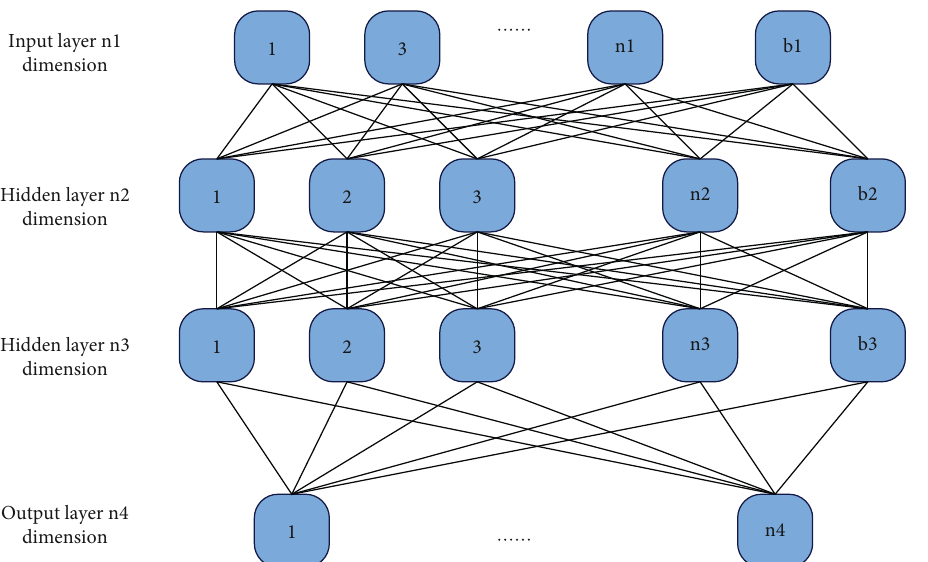
Figure 6: Schematic diagram of MLP neural network